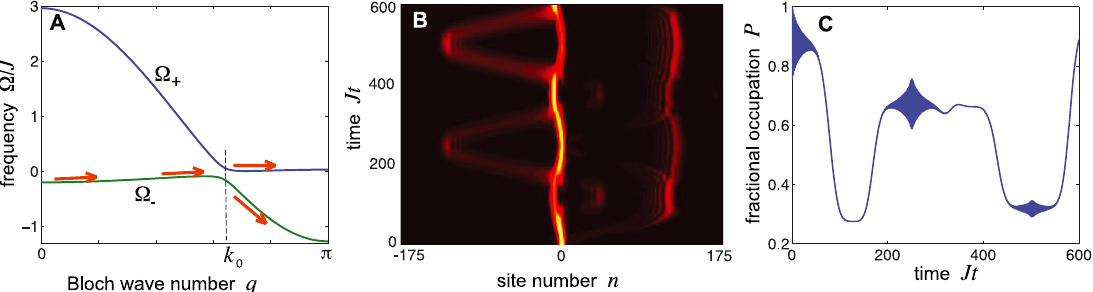
Figure 4: Same as Figure 3 , but for parameter values as in Figure 2A and for a gradient F ∕ J = 0 . 025. Note that, when the wave number q ( t ) of , excitation is split between the upper and lower bands Ω ± (solid arrows in panel the Gaussian wave packet reaches the crossing point q = k 0 (A)), and the entire wave packet undergoes an irregular motion, dubbed Bloch–Zener oscillations (panel (B)), with an aperiodic exchange of . Correspondingly, a large fraction of optical power can be optical power between the two bands as q ( t ) crosses the two-gap points q = ± k 0 transferred during the dynamics from the optical cavities (sublattice A) to the resonators of the CROW (sublattice B), as shown in panel